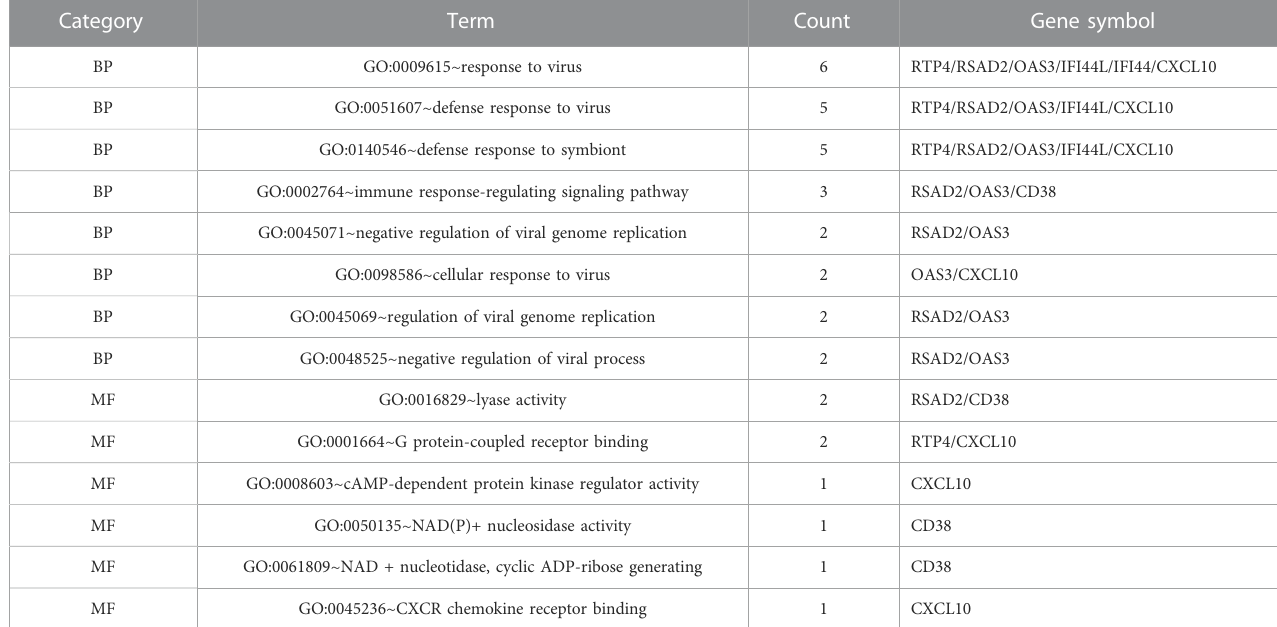
TABLE 1 Gene ontology analysis of Hub genes.